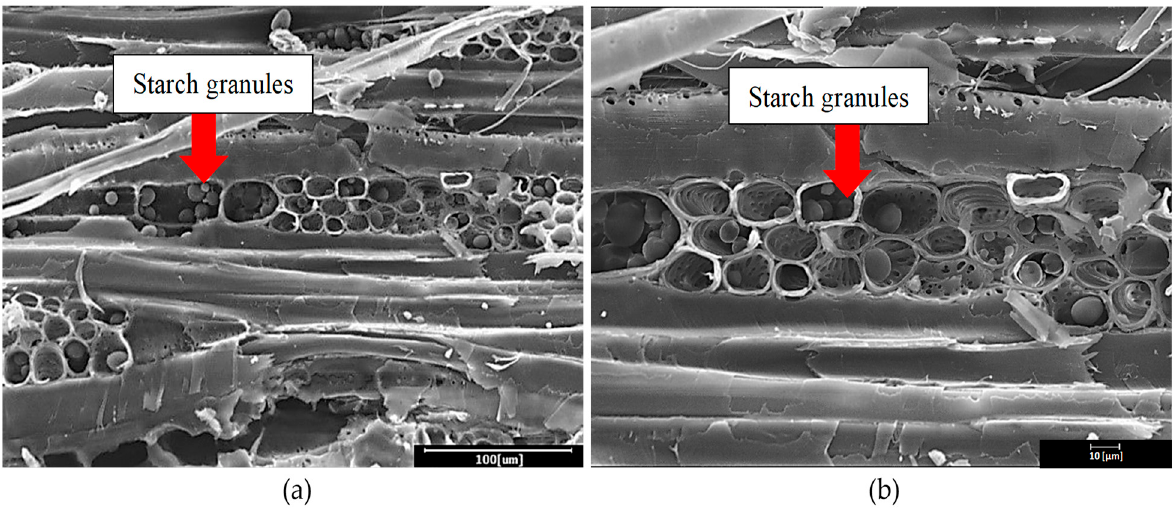
Figure 4. Starch granules stored in ray parenchyma cells of rubberwood ( a ) with 500× and ( b ) 1000× magnification.